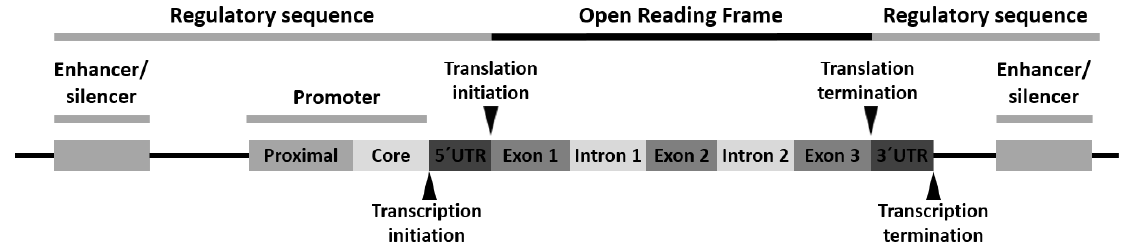
Figure 1. Schematic arrangement of a typical human gene with locations for gene